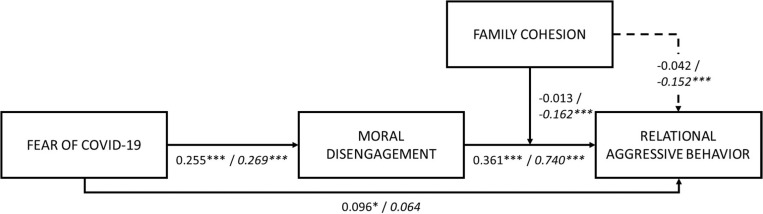
Model 4 Male/Female samples on relational aggression behavior. Male sample (RMSEA = 0.037, 90%CI [0.030, 0.043], CFI = 0.987, TLI = 0.984, SRMR = 0.043); Female sample (RMSEA = 0.036, 90%CI [0.033, 0.040], CFI = 0.981, TLI = 0.976, SRMR = 0.038); female sample coefficients given in italics.